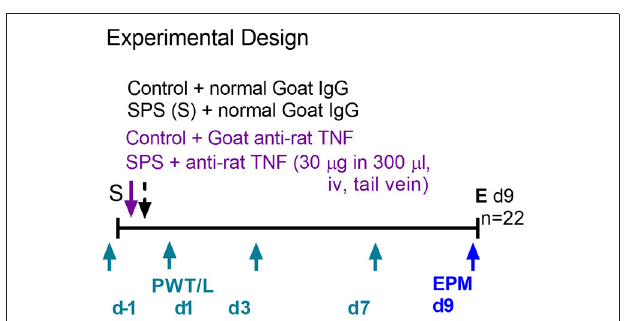
FIGURE 8 | Experimental design for anti-TNF- α antibody treatment in males. Female design was the same except nociceptive sensitivity assessments also were made on d9 ( n = 24 for female